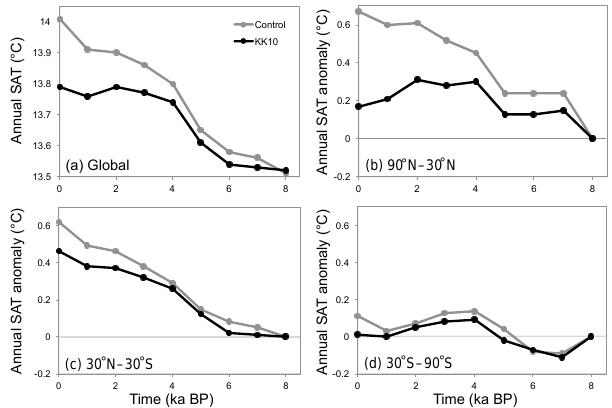
Figure 12. DJF snow depth anomalies (cm) for KK10 minus con- trol for the late pre-industrial period (1850CE). The stippling in- dicates grid boxes where the anomalies are significant at the 95% level using Wilcoxon rank sum statistical analysis.